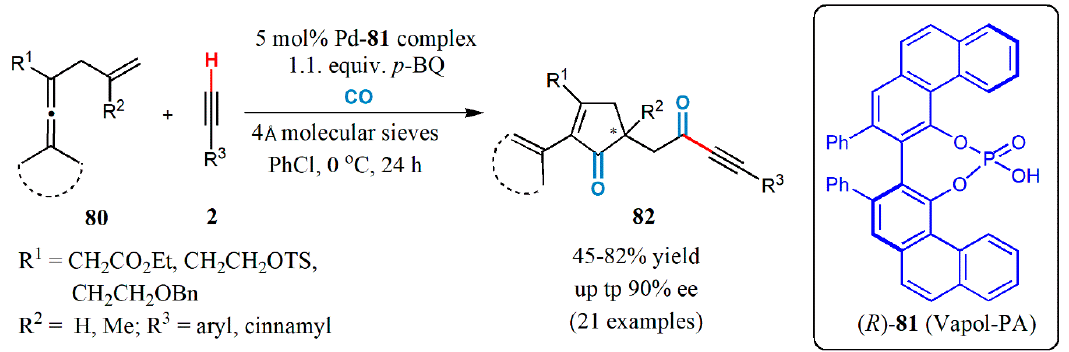
Figure 24. Palladium-catalyzed carbonylative carbocyclization of enallenes.